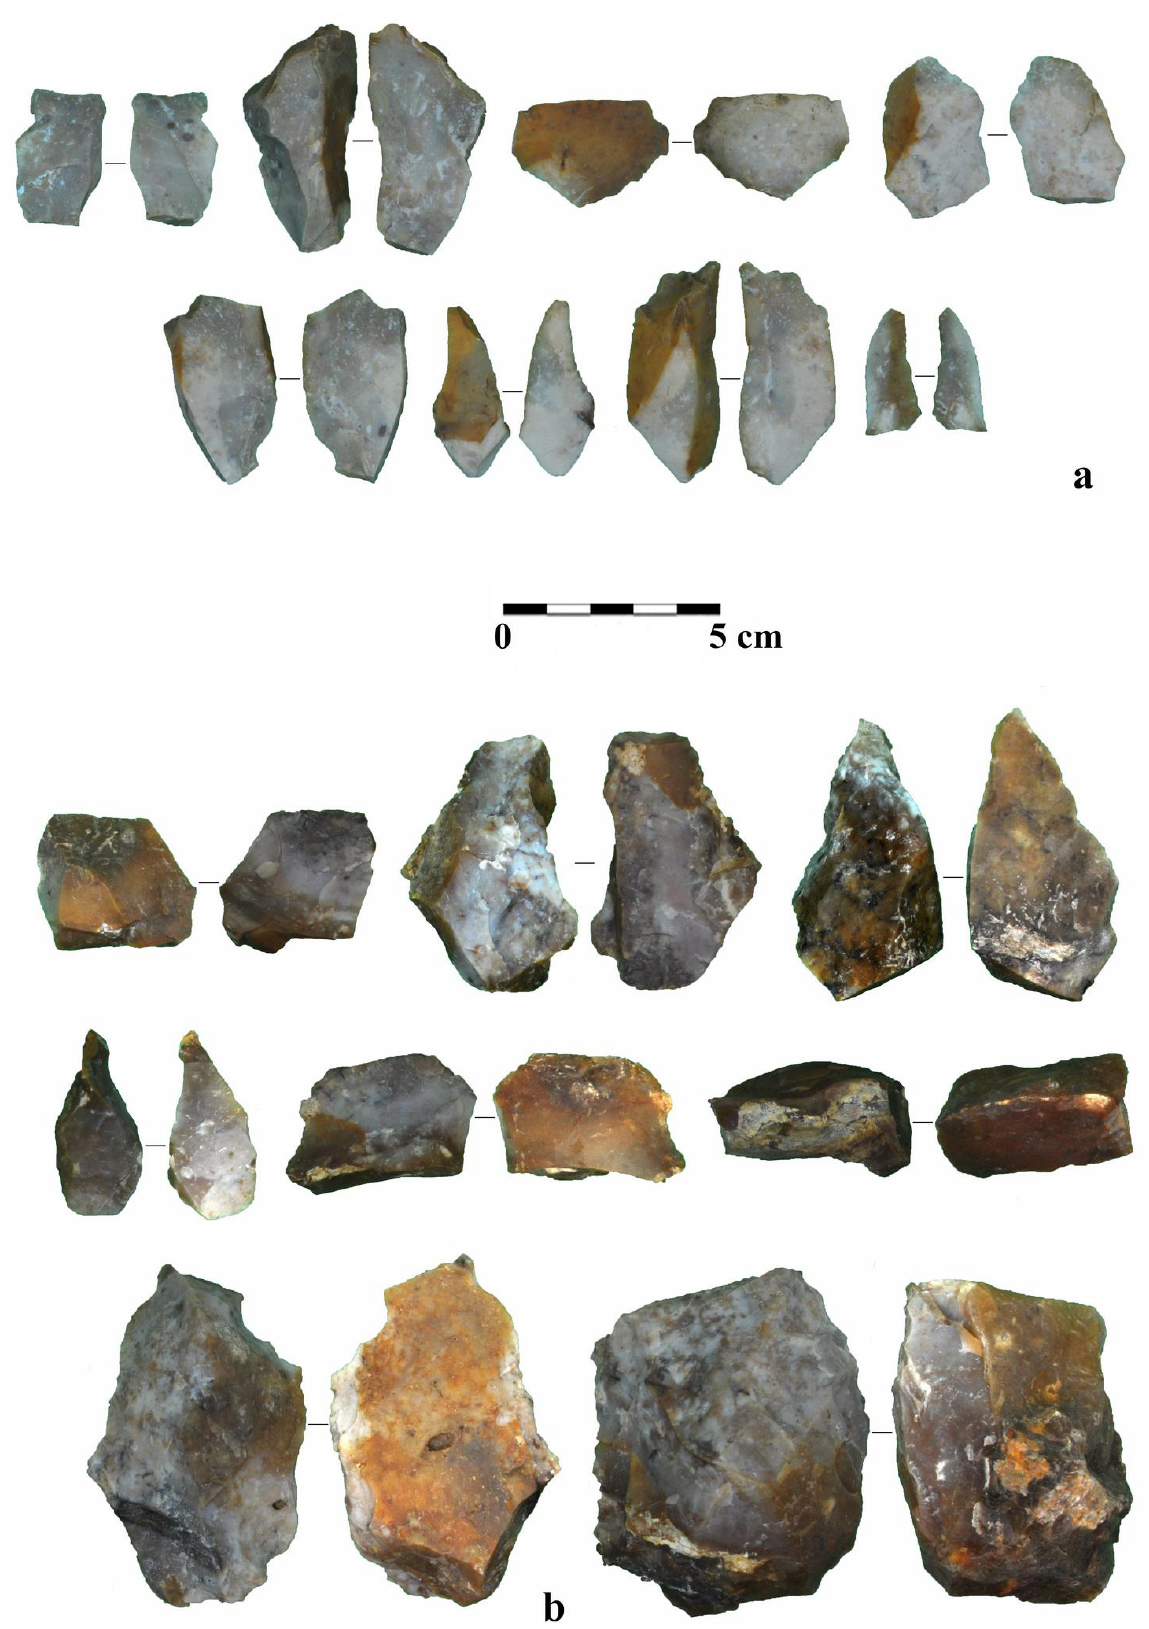
Figure 13. Experiment carried out by Jovan Galfi: a) whitish-grey part of opal; b) slightly darker part of